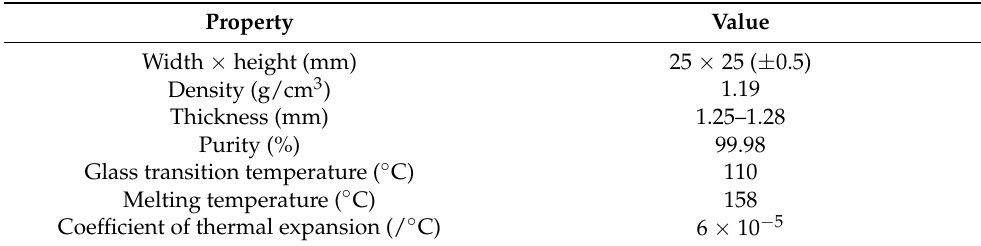
Table 1. Specifications of the PMMA in this study.